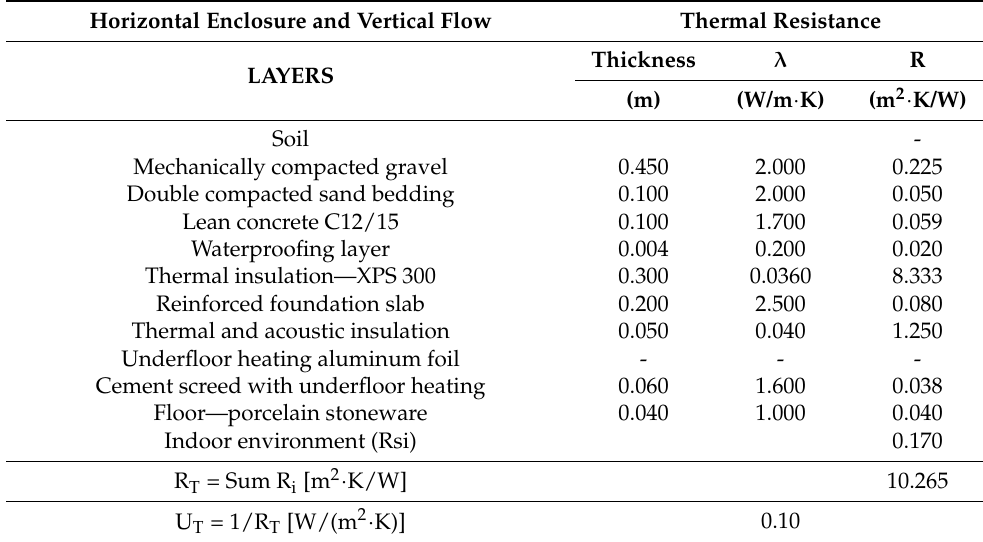
Table 3. U -value of the heat transfer coefficient for the foundation slab— U g